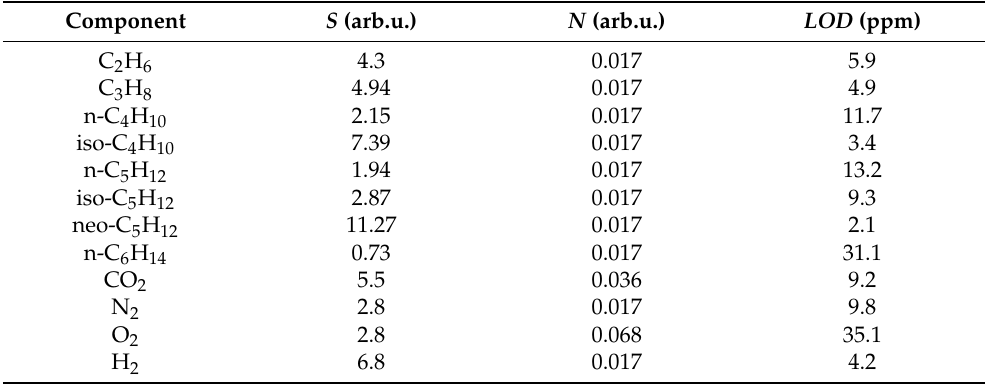
Figure 7. Difference between two successive spectra of sample 1. Table 6. Parameters for Equation (3) and limits of detection of the Raman natural gas analyzer.